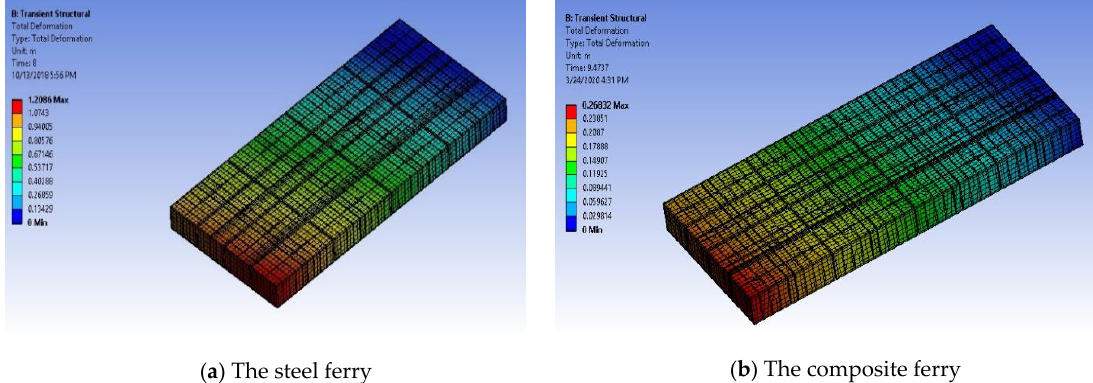
Figure 23. The total deformation distribution in case of loading 2.